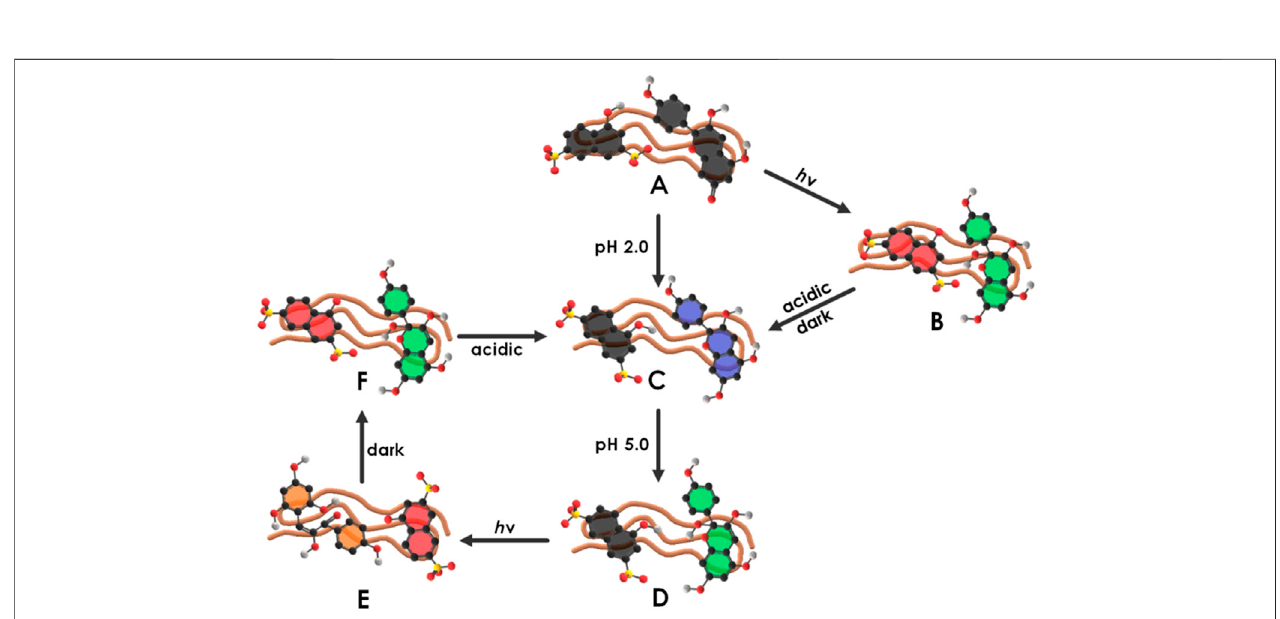
FIGURE 26 | A ternary multiswitchable assembly formed of Flavy, a photoacid (1N36S) and linear poly (allylamine) (simpli fi ed schematic representation displaying one molecule of each component per assembly only). (A) : The protonated photoacid and Flavy in its closed form. (B) : The deprotonated photoacid and hydroxylated Flavy. (C) : The protonated photoacid and protonated Flavy. (D) : The protonated photoacid and hydroxylated Flavy. (E) : The deprotonated photoacid and open Flavy. (F) : The deprotonated photoacid and hydroxylated Flavy (Zika and Gröhn, 2021). The Figure was reproduced, © 2021 A. Zika and F. Gröhn, distributed under